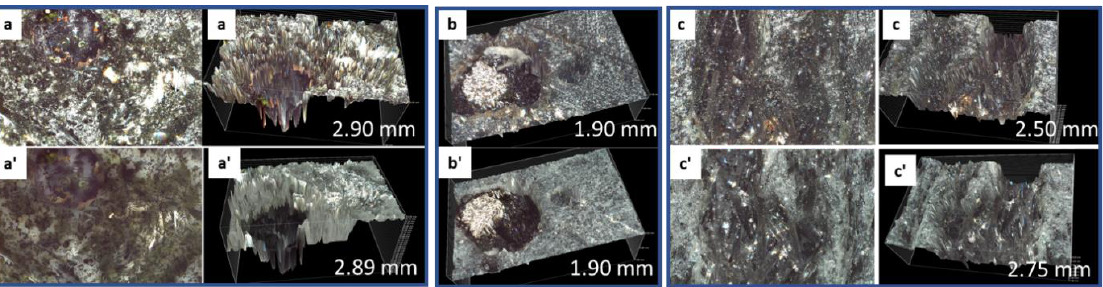
Figure 6. 3D images of mullite before (top row: ( a – c )) and after (bottom row: ( a’ – c’ )) the acid exposure for three different sites. The numbers indicate the depth of the sample features on 3D images.